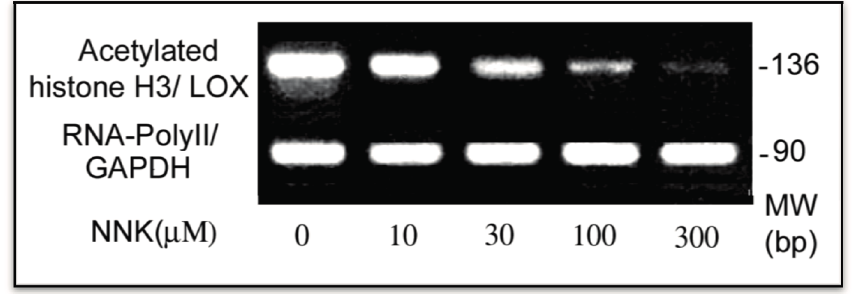
Figure 6. Inactivation of the LOX core promoter in NNK treated cells. ChIP and PCR assays were performed to elucidate the active status of the LOX core promoter in treated cells by assessing acetylated histone H3 binding to the core promoter region. DNAs were isolated from control and NNK treated cells each with 2 × 10 6 , sonicated and immunoprecipitated with an antibody against acetylated histone H3 or RNA-PolyII. Using immunoprecipitated DNA as a template, the PCR with primer pairs as shown under Methods amplified the acetylated histone H3-bound LOX core promoter region with 136 bp, and the RNA-Poly II bound fragment of the GAPDH promoter (an internal control) with 90 bp, respectively. PCR products were analyzed on 2.2% agarose gels and densities of DNA bands measured by the 1D Scan